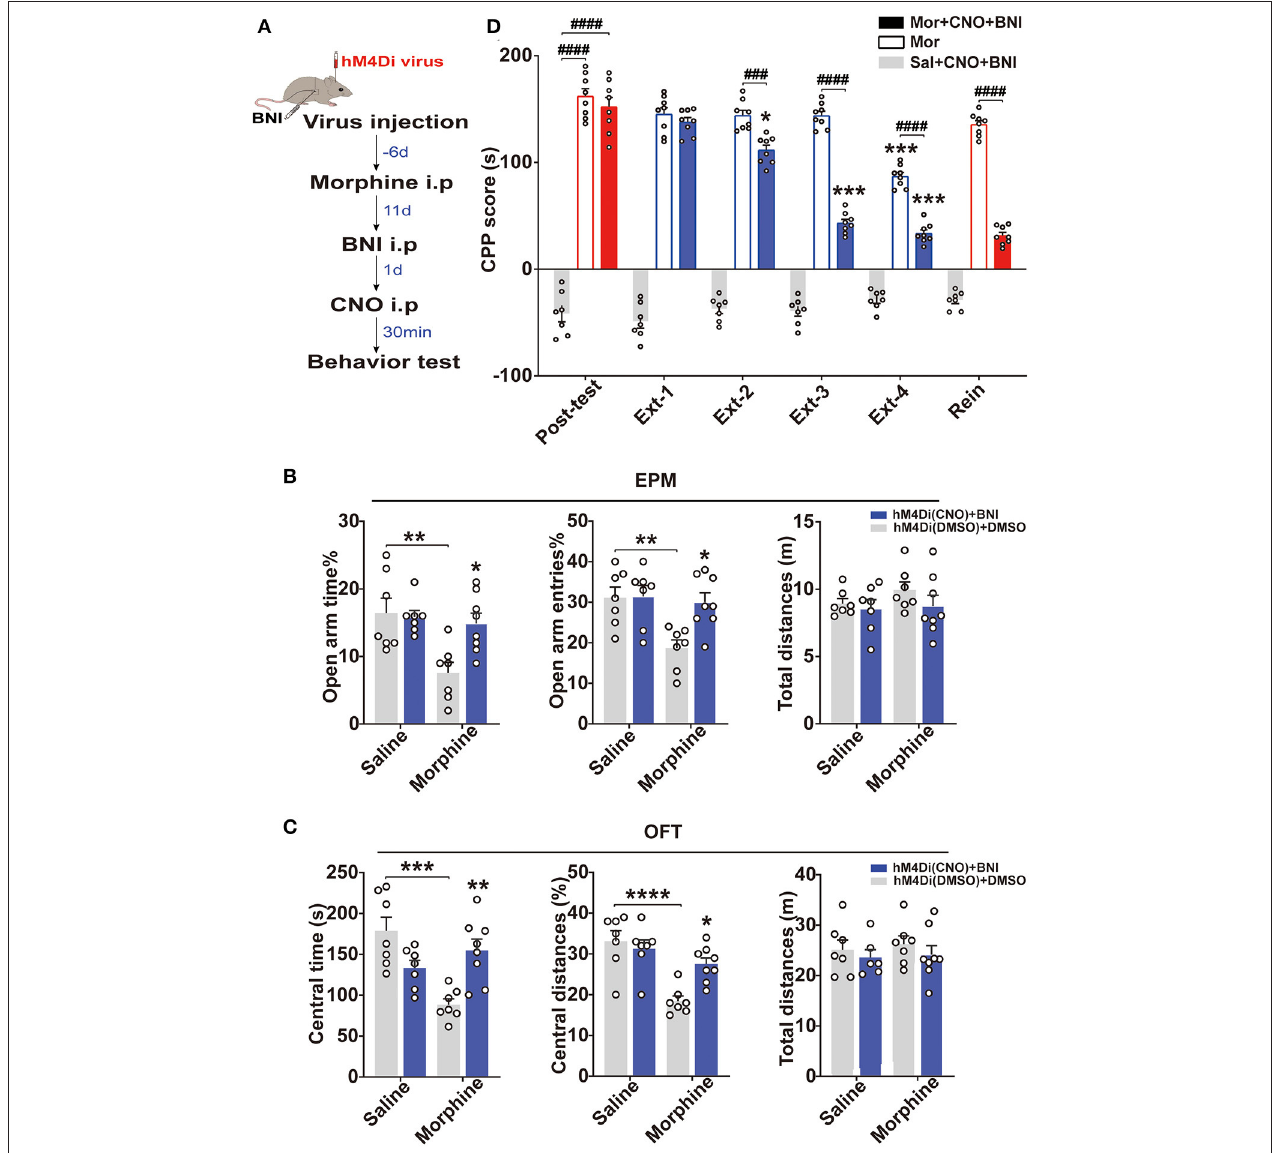
FIGURE 5 | The simultaneous intervention of KORs and the BLA to vHip projections prevented the reinstatement of morphine CPP and anxiety-like behaviors in morphine-withdrawn mice. (A) Timeline of experiment. (B) The inhibition of the BLA to vHip projections combined with nor-BNI administration increased the open-arm time in and entries into the EPM by the Mor-A mice. (C) The inhibition of the BLA to vHip projections combined with nor-BNI administration increased the time spent and distances traveled in the central area of the OFT by the Mor-A mice. In (B,C) , the blue histogram represents the hM4Di (CNO) + BNI group, in which the mice were first injected with the chemogenetic virus (hM4Di). Then, the mice morphine withdrawal anxiety model was constructed, and BNI was injected 2 weeks after withdrawal. The next day, the mice were injected with CNO and tested for anxiety-like behavior 30min later. CNO and BNI were dissolved in 0.5% DMSO. The white histogram represents the hM4Di (DMSO) + DMSO group. (D) The inhibition of the BLA to vHip projections combined with nor-BNI administration prevented the reinstatement of morphine CPP. nor-BNI: a long-lasting KOR antagonist. Data are expressed as the mean ± SEM. In the CPP results, *: comparison between the extinction group and the post-test group. #: comparison between the 2 indicated groups. n = 7–10/group. * P < 0.05, ** P < 0.01, *** P < 0.001, **** P < 0.0001, ### P < 0.001, #### P <